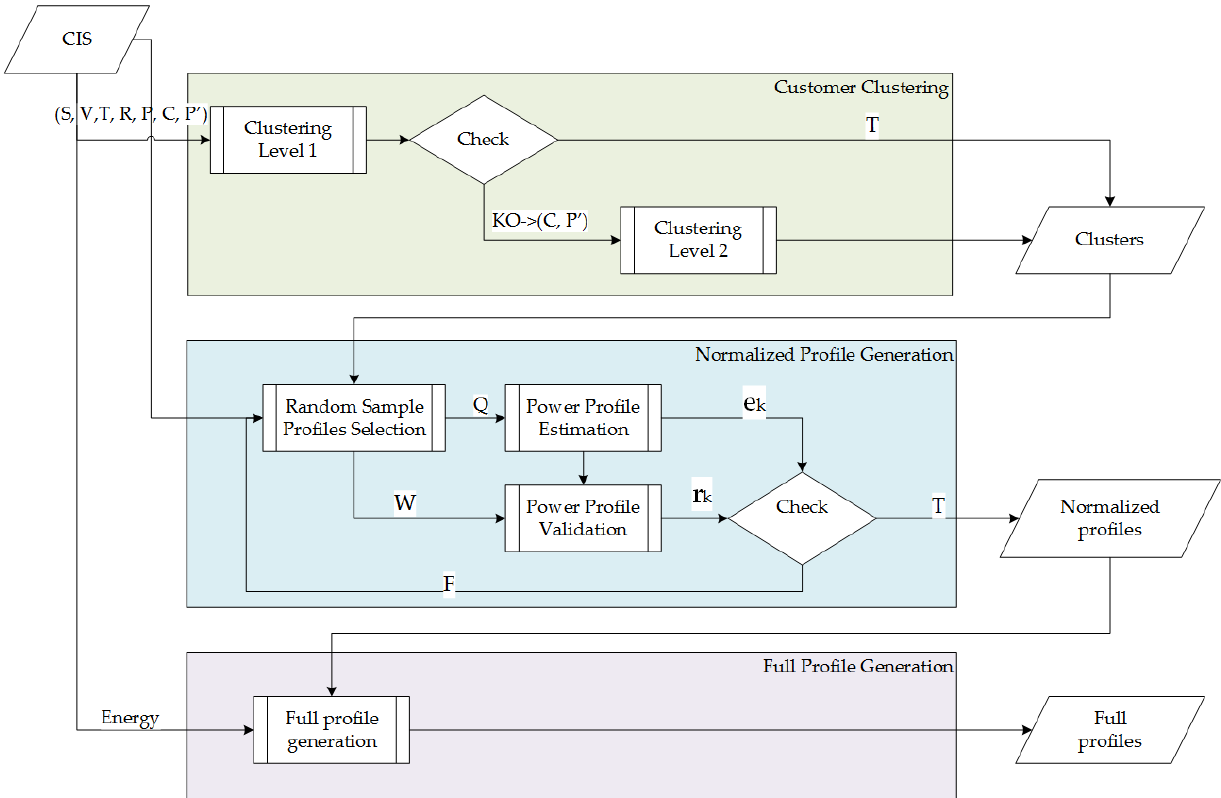
Figure 3. The flow diagram used to generate massive power profiles.